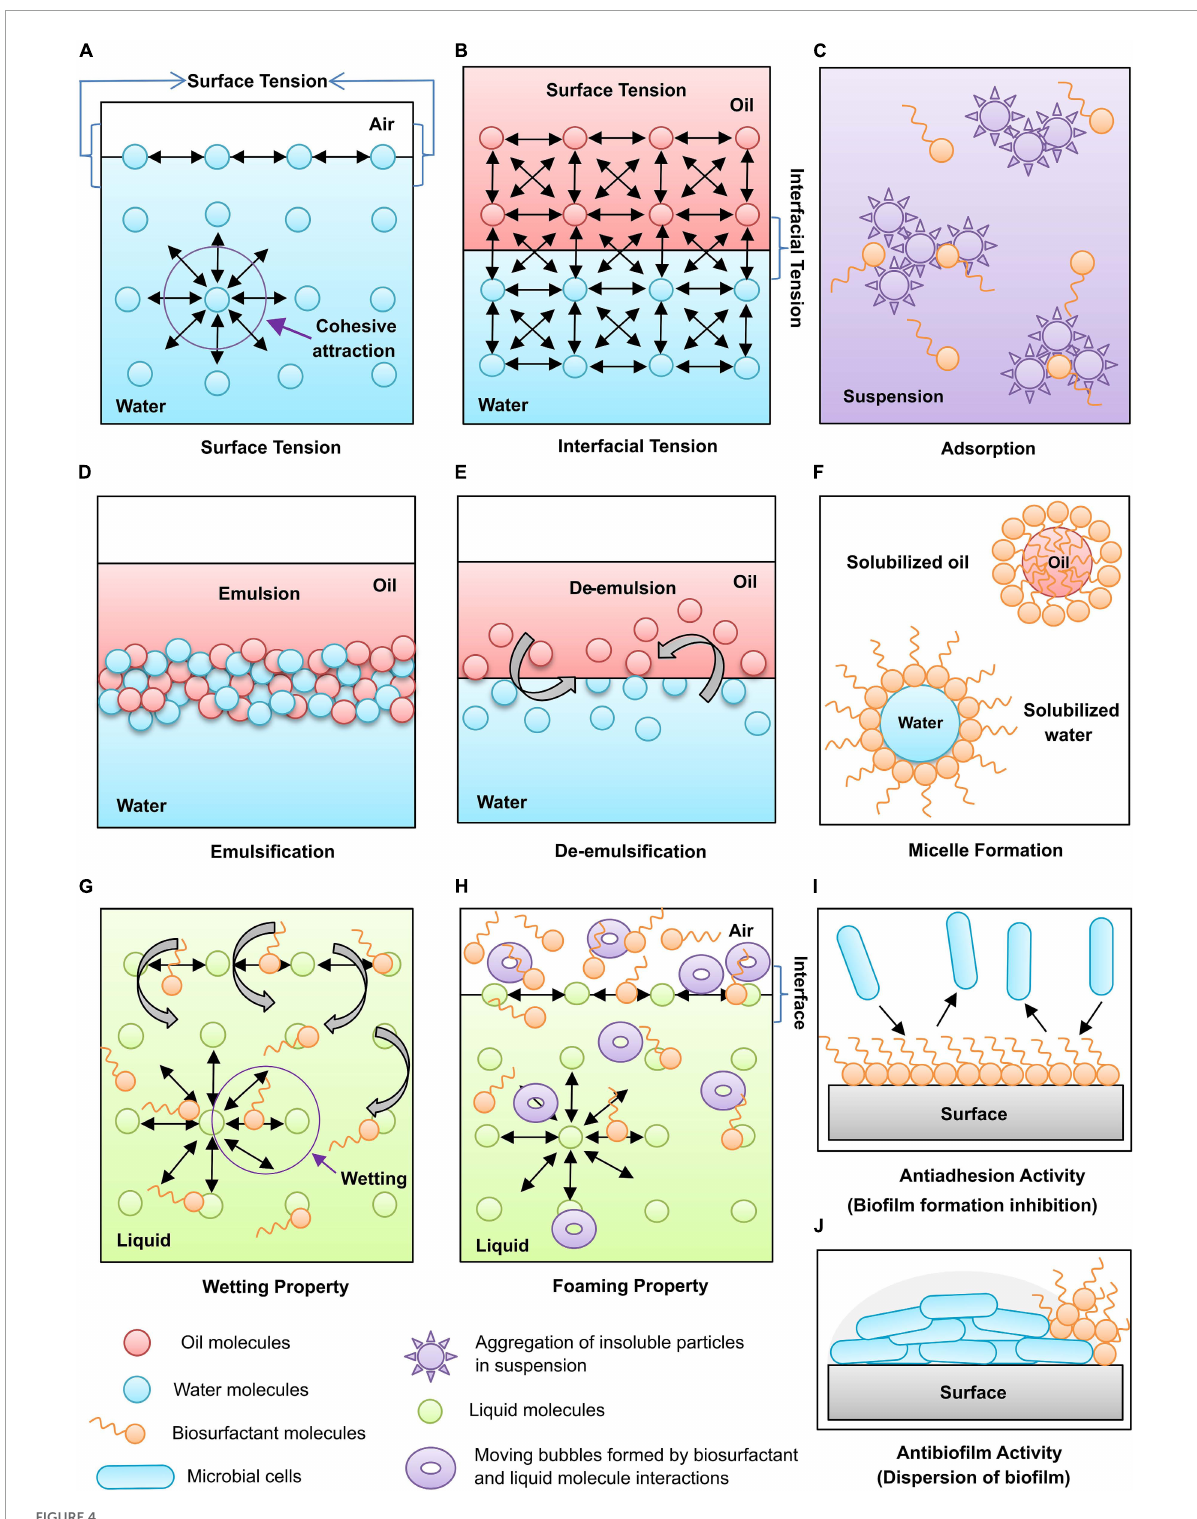
FIGURE4 Functional properties of biosurfactants: (A) Surface tension, (B) Interfacial tension, (C) Adsorption, (D) Emulsification, (E) De-emulsification, (F) Micelle formation, (G) Wetting property, (H) Foaming property, (I) Antiadhesion activity, and (J) Antibiofilm